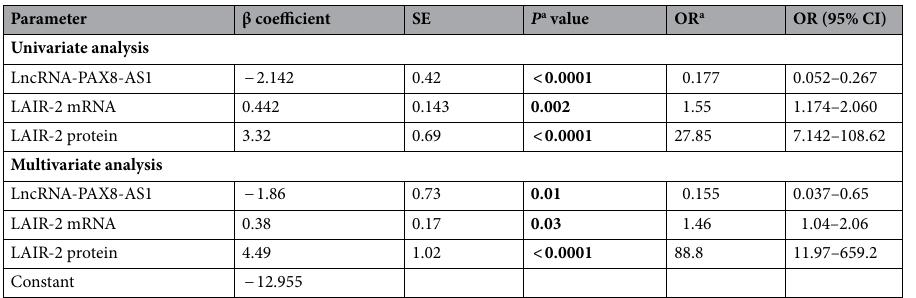
Table 7. Logistic regression analysis to predict the risk of subclinical hypothyroidism. Subclinical hypothyroidism (n = 110) versus healthy controls (n = 95). Log likelihood of the stepwise